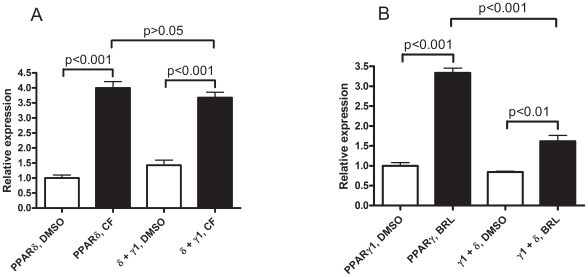
The effect of (A) non-liganded PPARγ1 on PPARδ signalling and of (B) non-liganded PPARδ on PPARγ1 signalling.COS-1 cells were transiently transfected with (per well in six-well plates) 50 ng (A) pCLDN-hPPARδ or (B) pCDLN-hPPARγ1 and 250 ng (A) pCLDN or pCLDN-hPPARγ1 and (B) pCLDN or pCLDN-hPPARδ, respectively.